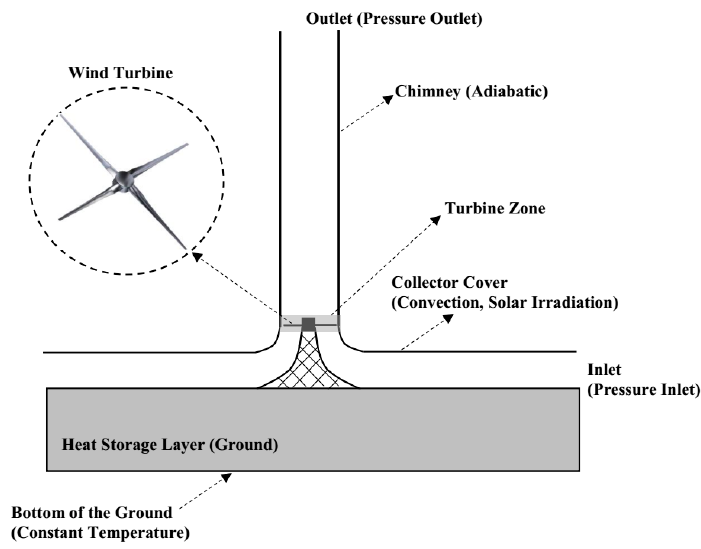
Figure 1. Schematic of a Solar Chimney Power Plant and Boundary Conditions. Table 1. Constructed dimensions of the Manzanares prototype solar chimney power plant (SCPP).